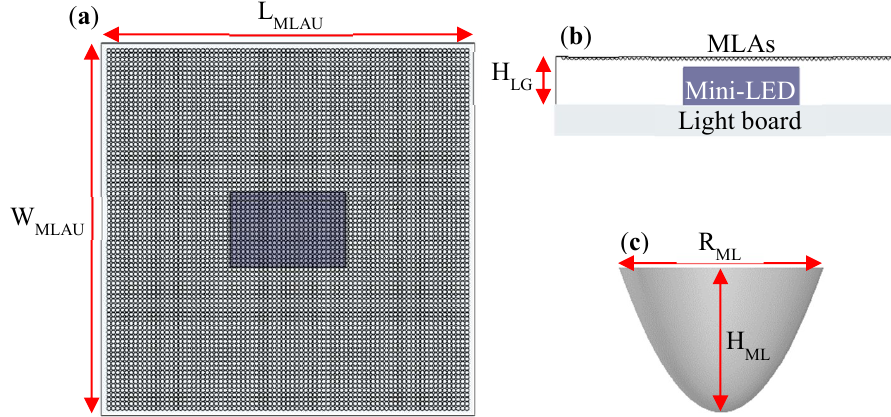
Figure 8. 3D structure of the MLA unit module: ( a ) top view; ( b ) side view; ( c ) single microstructure of the MLA.